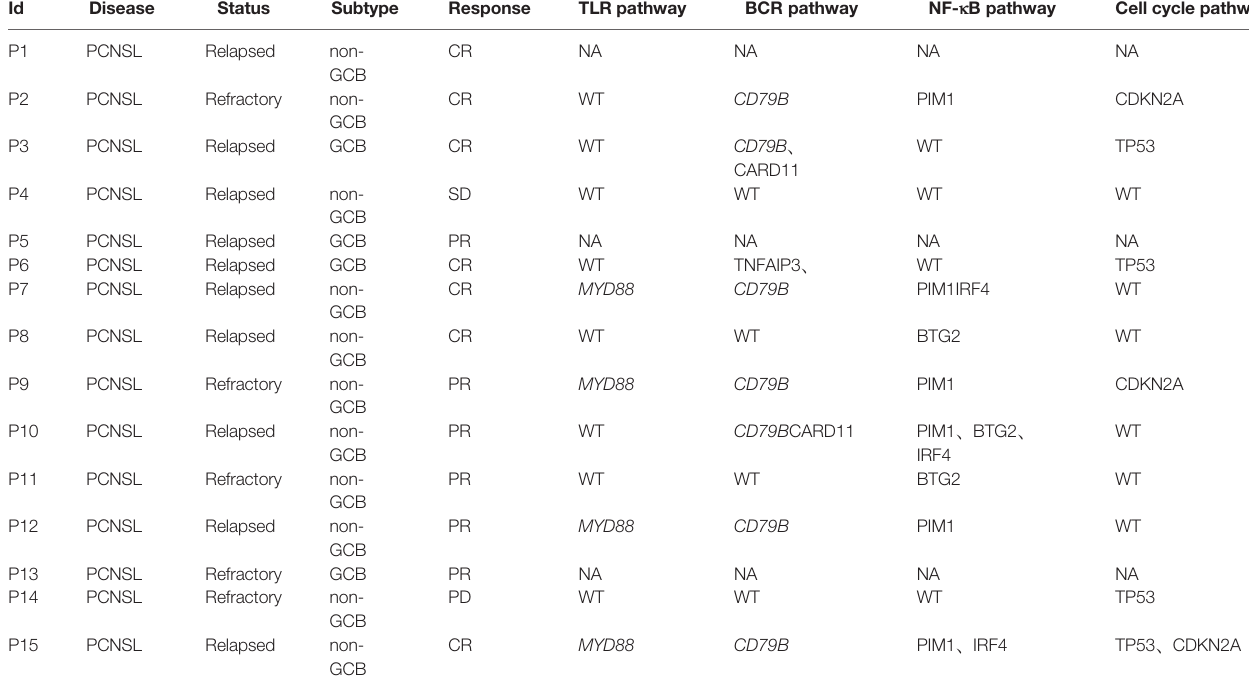
TABLE 2 | Gene mutations in pathways in pretreatment tumor tissue. Id